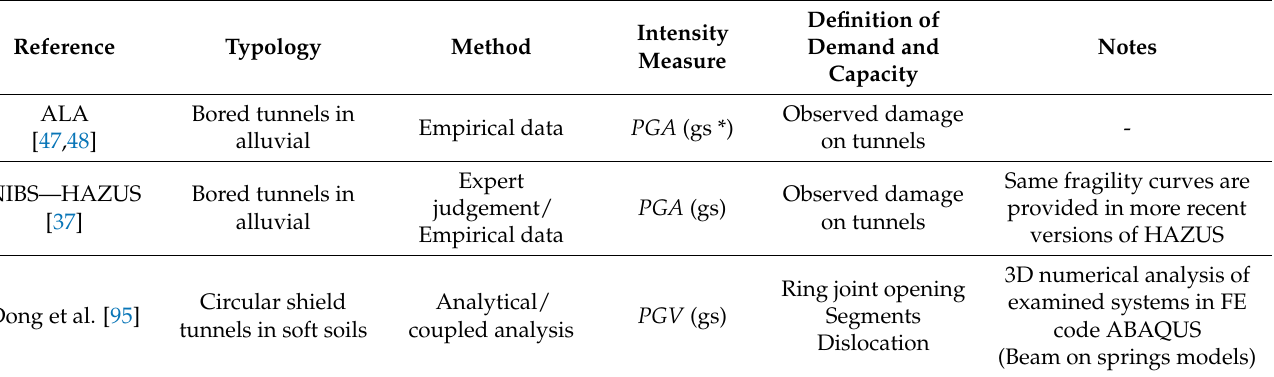
Table 5. Studies on seismic fragility assessment of tunnels and underground structures subjected to ground seismic shaking in the longitudinal